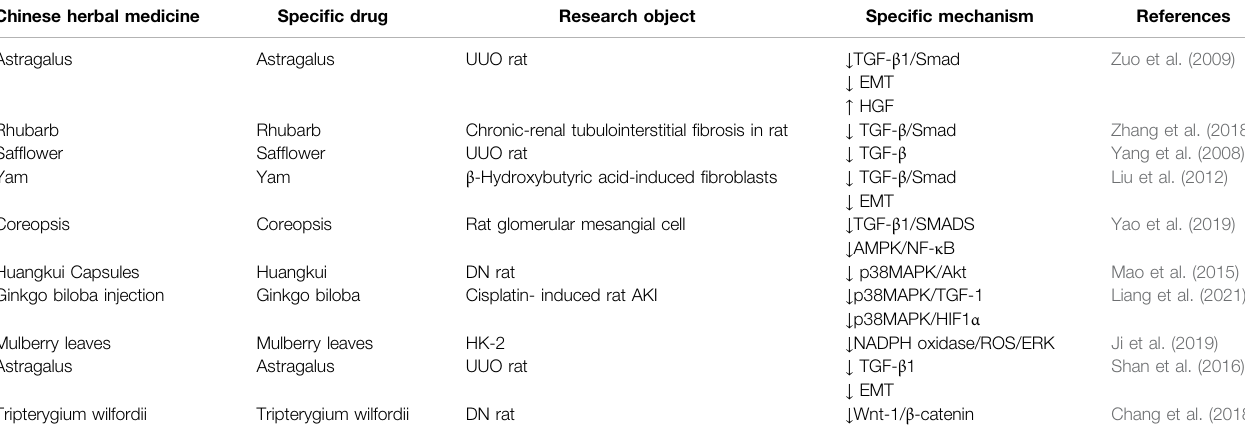
TABLE 1 | Summary of Chinese herbal medicines that improve RIF-related mechanisms Single